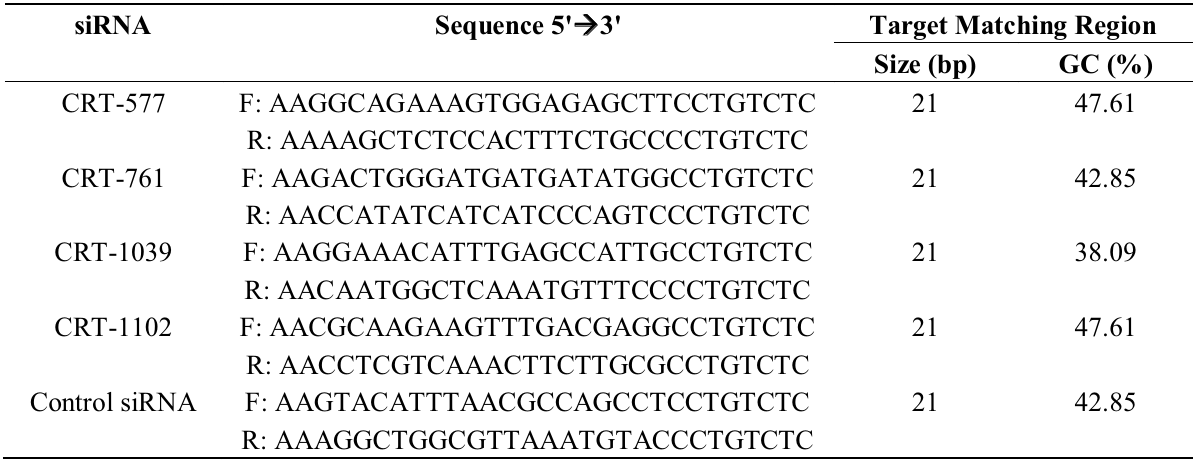
Table 1. Small interfering RNAs used in this study. siRNAs were named according to their position on the Mi-CRT (AF402771.1) coding sequence. F = Forward